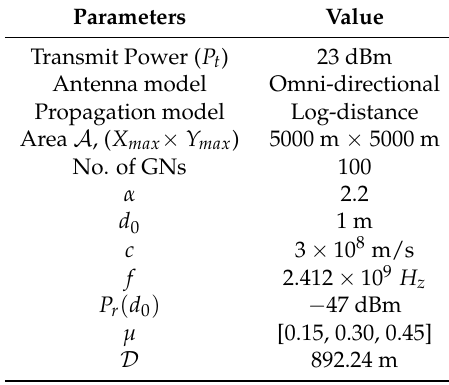
Table 3. Parameters in each scenario.